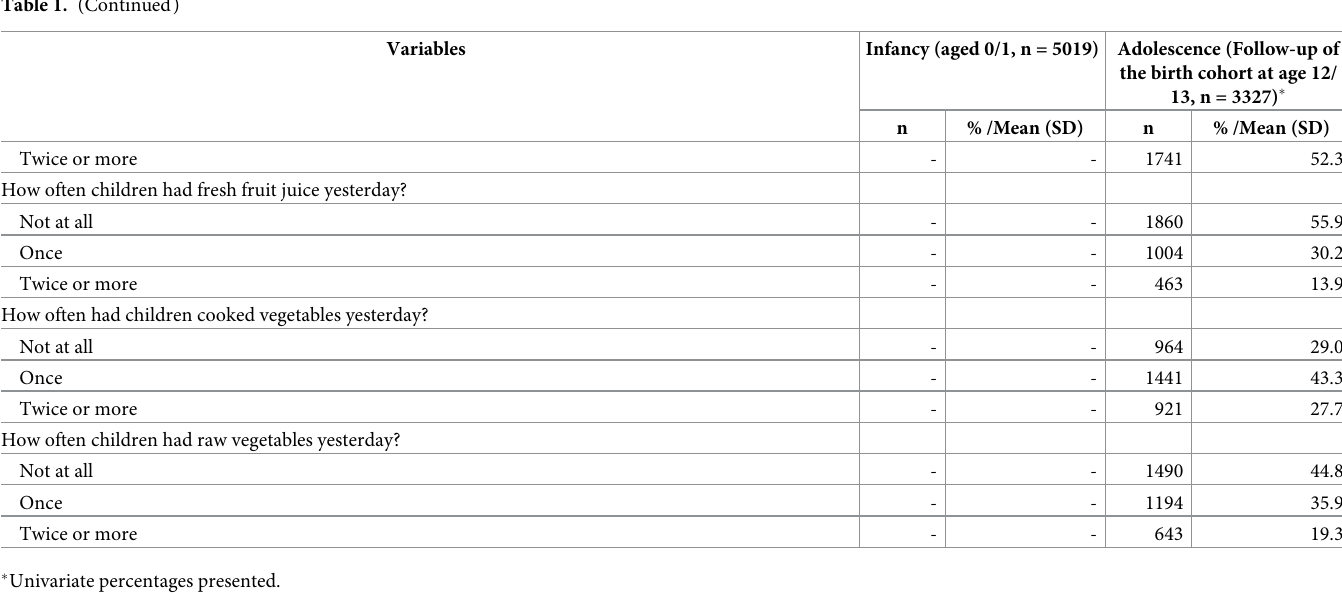
status. We found that poor general health of mothers in the year after childbirth increased the likelihood of poor general health of their children during infancy (OR: 3.13, 95% CI: 2.16– 4.52) and adolescence (OR: 1.39, 95% CI: 0.95–2.04). This study also finds that stress, anxiety, or depression during pregnancy and one or more stressful life events among mothers in the year after childbirth were associated with the poor general health of the children, but only dur- ing adolescence. The associations revealed in Table 2 were medium to large in effect size, while the magnitudes were higher in the associations of poor maternal general health and poor gen- eral health of children for infants, compared to adolescents. Table 3 reports the associations between the mothers’ health and health-related behaviours and their children’s chronic health condition. The presence of a chronic condition during pregnancy significantly increased the likelihood of a chronic condition in the offspring during infancy (OR: 1.31, 95% CI: 1.12–1.54) and during adolescence (OR: 1.45, 95% CI: 1.20–1.75).